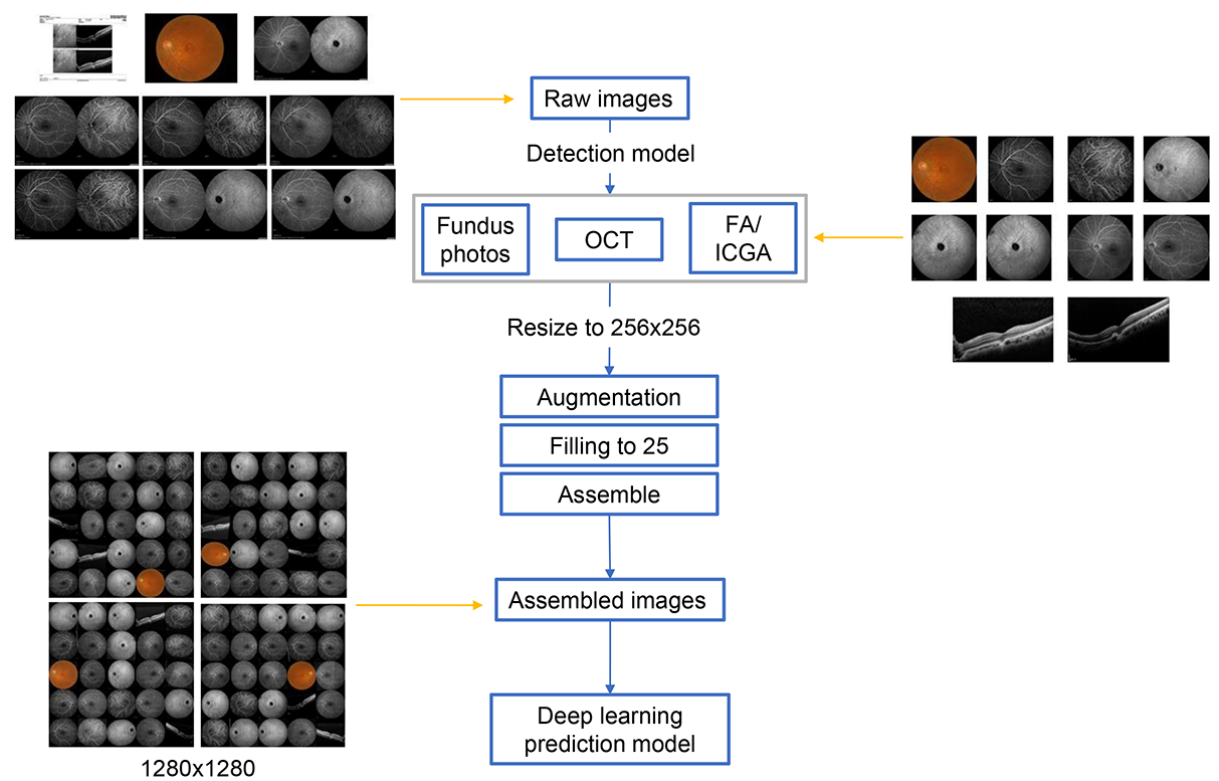
Figure 1. Flowchart of multimodal image management and processing. OCT: optical coherence tomography; FA/ICGA: fluorescein angiography with or without indocyanine green